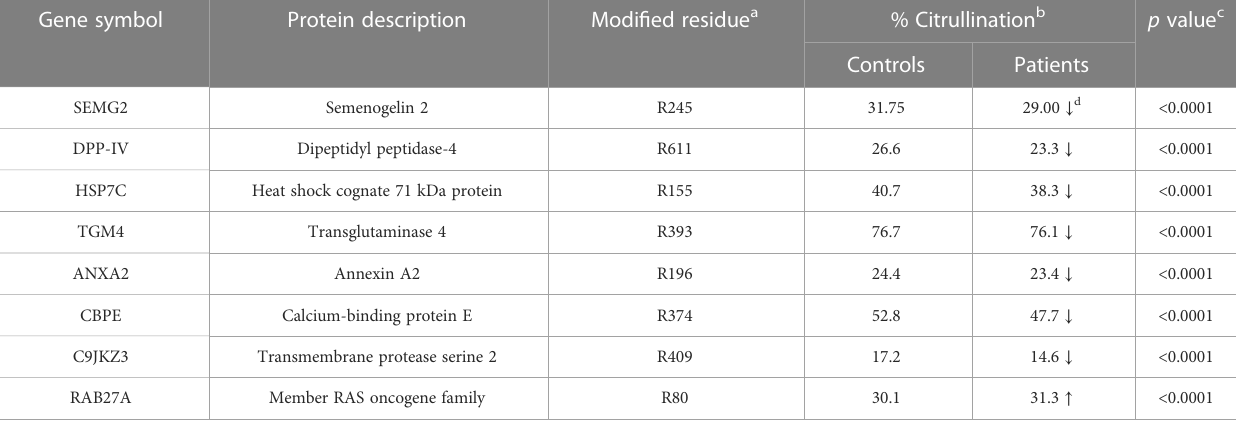
TABLE 2 Stoichiometric analysis of protein citrullination in sEV proteomes of non-normozoospermic (non-NZ) men compared to normozoospermic (NZ) healthy controls. Gene symbol